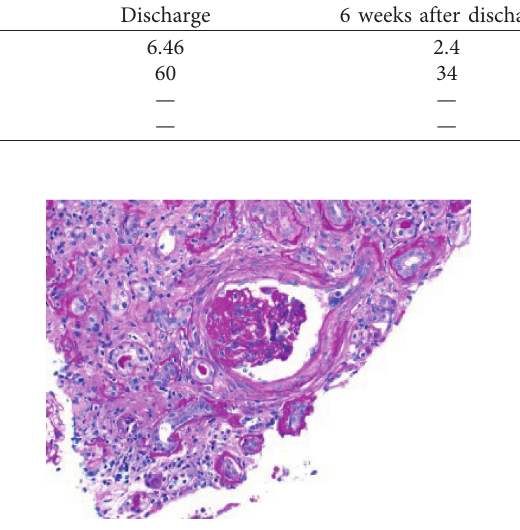
Figure 3: Segmental sclerosis and periglomerular fibrosis with tuft